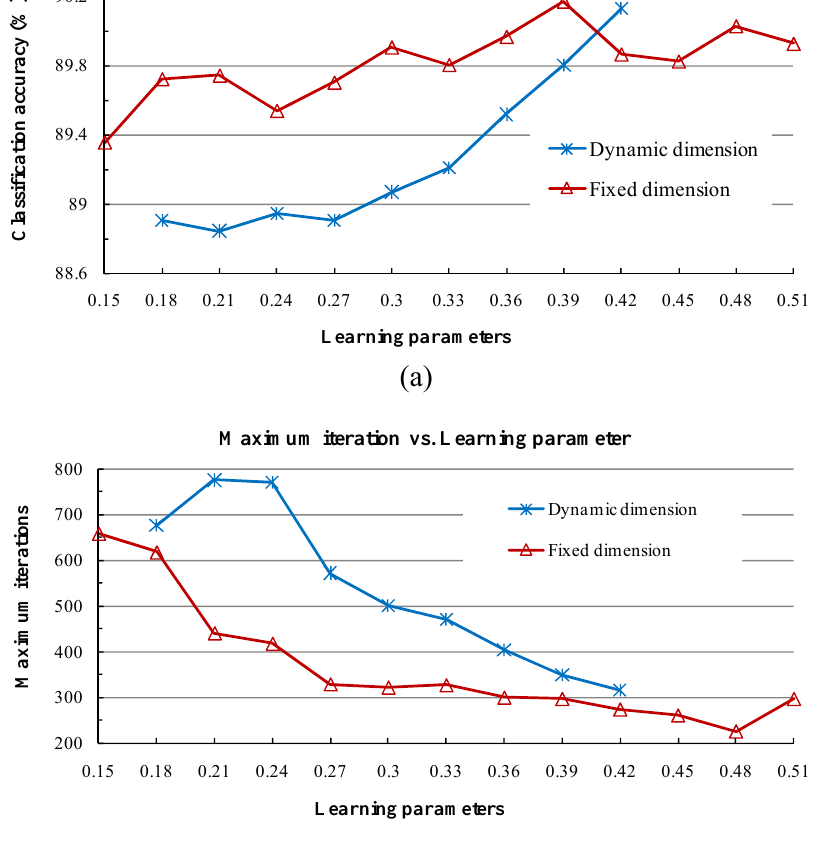
Figure 2. Classification accuracy and maximum training iterations as a function of learning parameters combined with [-1, +1] normalization. (a) Classification accuracy by the dynamic subspace method and classification accuracy by the fixed subspace method (b) maximum learning iterations by the dynamic subspace method and maximum learning iterations by the fixed subspace method. The fidelity value in the dynamic subspace method was 0.99985 and the dimension in the fixed subspace method was 5. Classification accuracy vs. Learning parameter